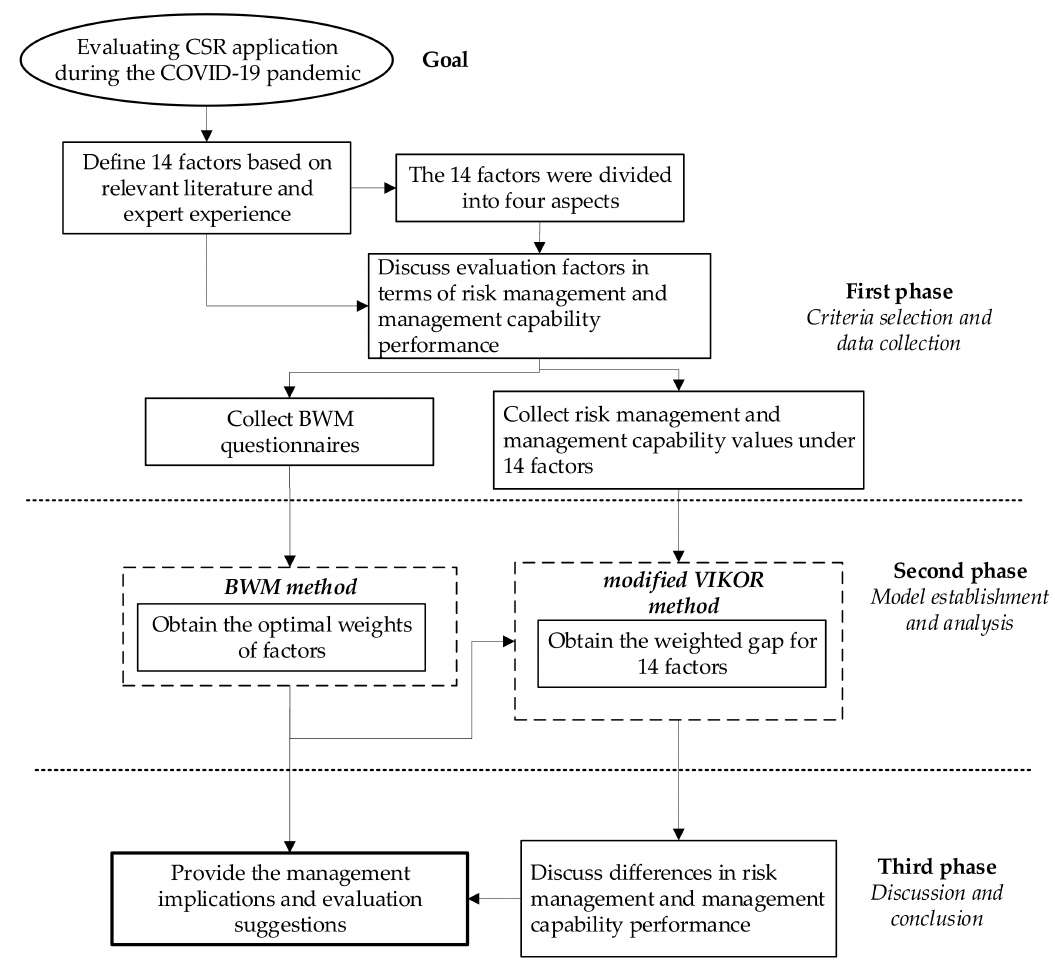
Figure 1. Procedure of the current